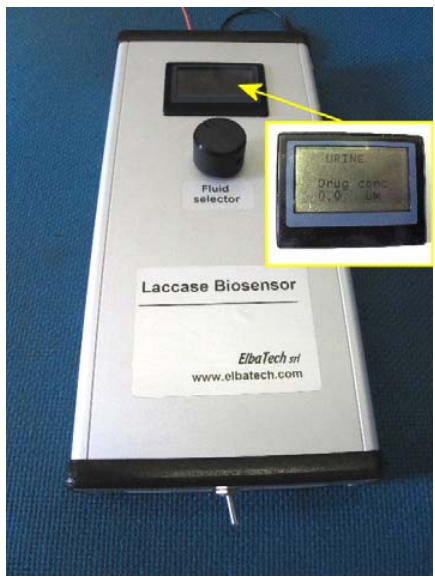
Figure 9. Prototype of laccase sensor jointly constructed with Elbatech Srl, Marciana (LI), Italy, compact and portable for all fluids indicated in Table 3.